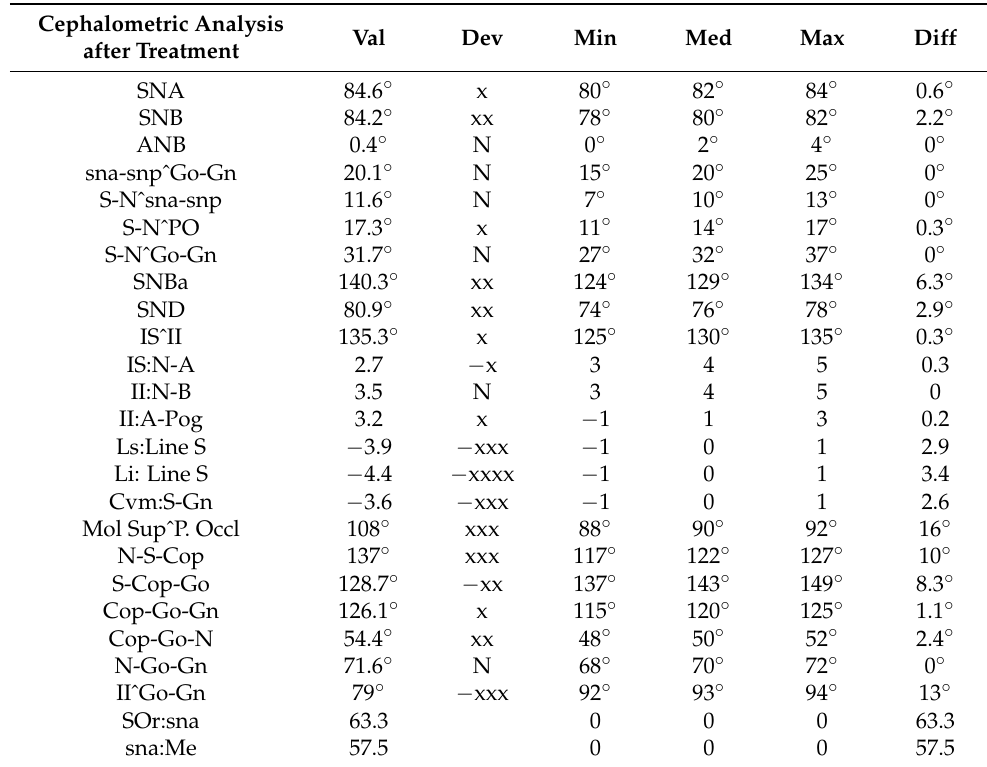
Figure 20. Cephalometric tracing (DeltaDent software) after treatment shows a skeletal class I (8-year-old). Table 4. Cephalometric analysis after treatment.